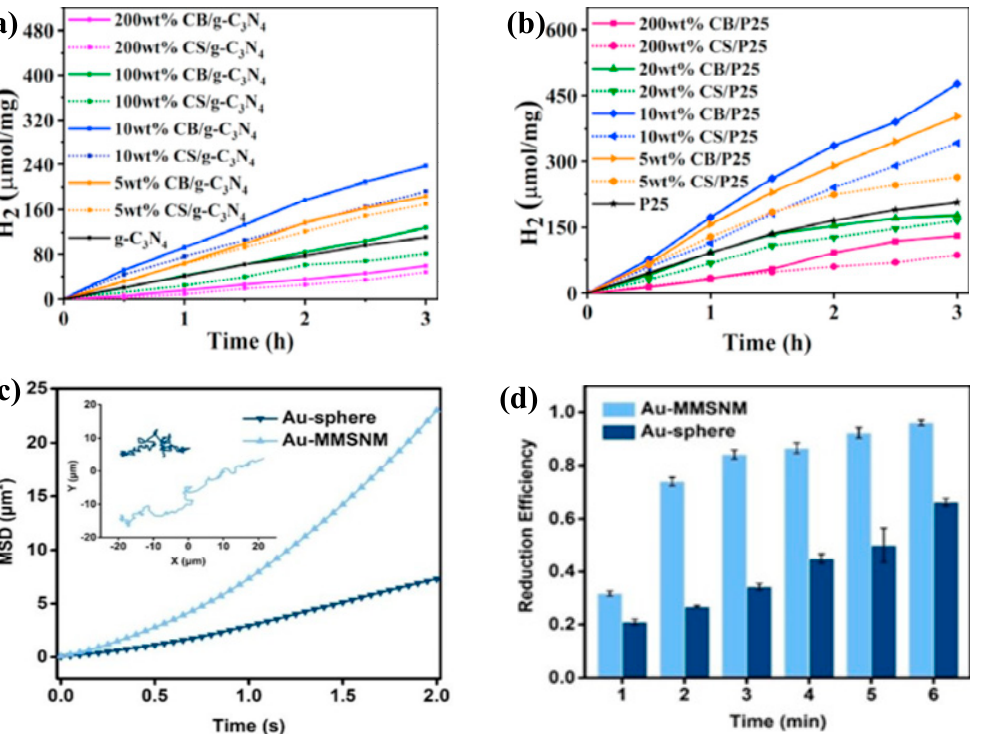
Figure 8. ( a , b ) Photocatalytic hydrogen production activities of with or without nanobottle motors. Reprinted with permission from Ref. [37]. Copyright 2021, copyright Elsevier Ltd. ( c ) Motion Trajectories and ( d ) reduction rate of Au-nanobottle motors, Au sphere. Reprinted with permission from Ref. [43]. Copyright 2022, copyright Wiley-VCH GmbH.